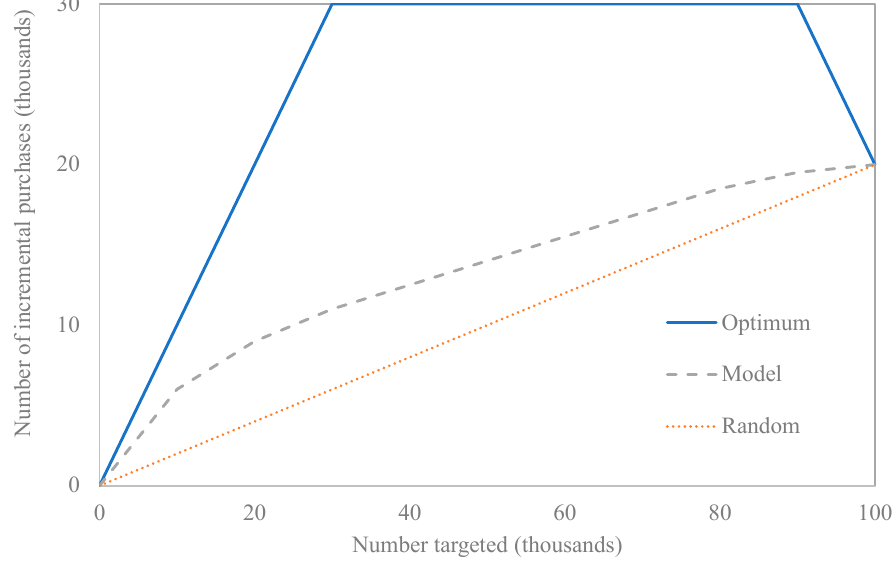
Figure 3. Typical Qini curve for Uplift model evaluation, used in Econometrics.